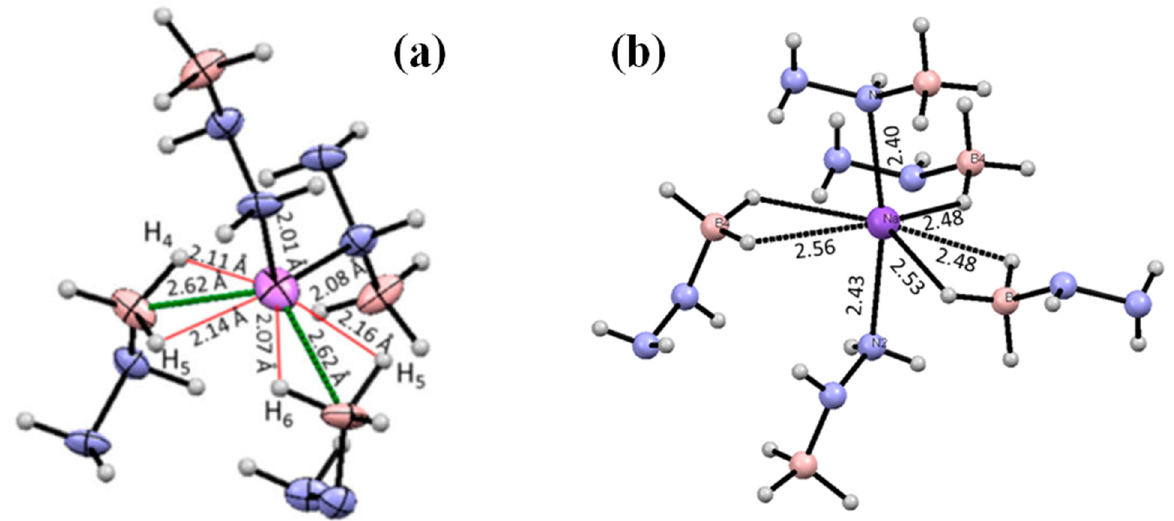
Figure 7. ( a ) Coordination of Li + in lithium hydrazinidoborane LiN 2 H 3 BH 3 (reprinted with permission from [66]; copyright 2014 American Chemical Society); ( b ) Coordination of Na + in sodium hydrazinidoborane NaN 2 H 3 BH 3 (reprinted with permission from [71]; copyright 2013